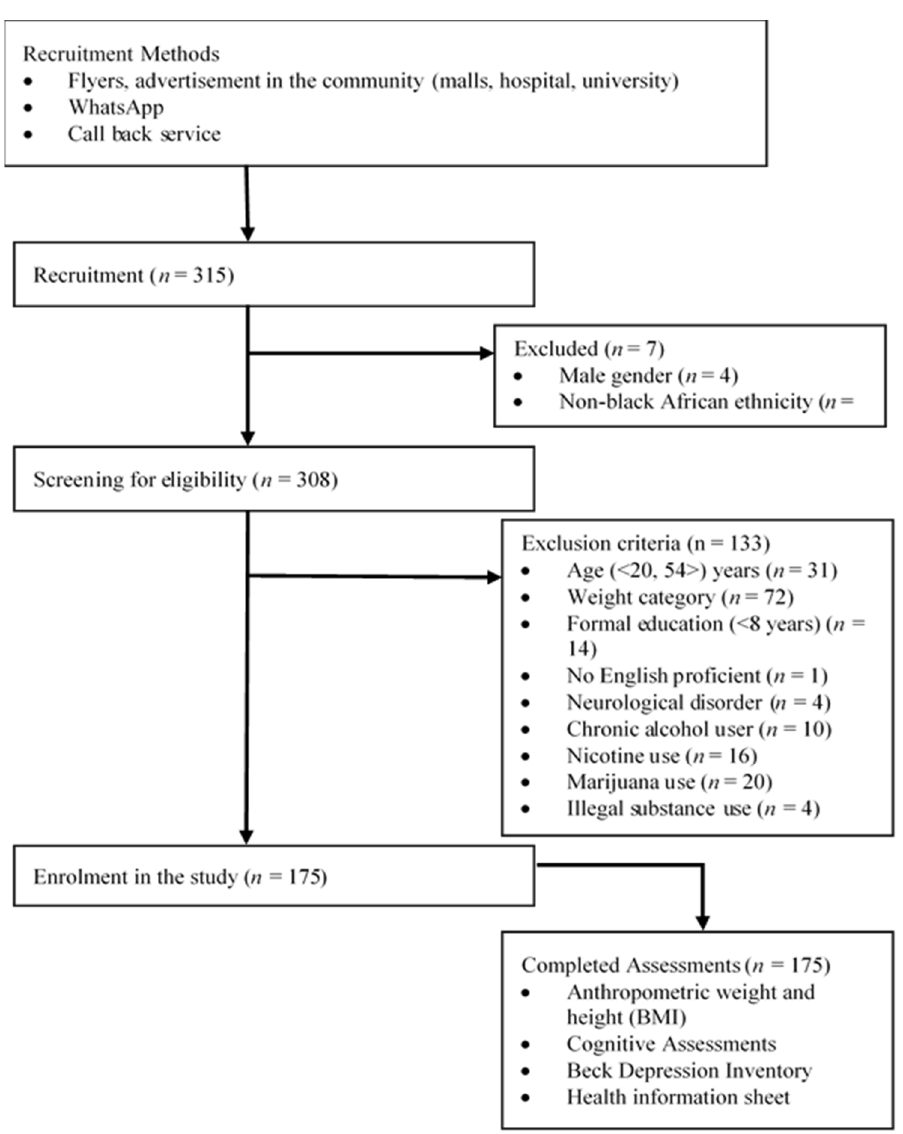
Figure 1. Flow chart of the study recruitment procedure.